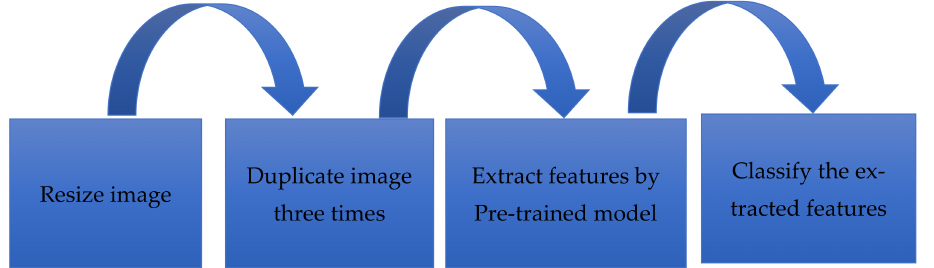
Figure 4. The overall process of the proposed method.